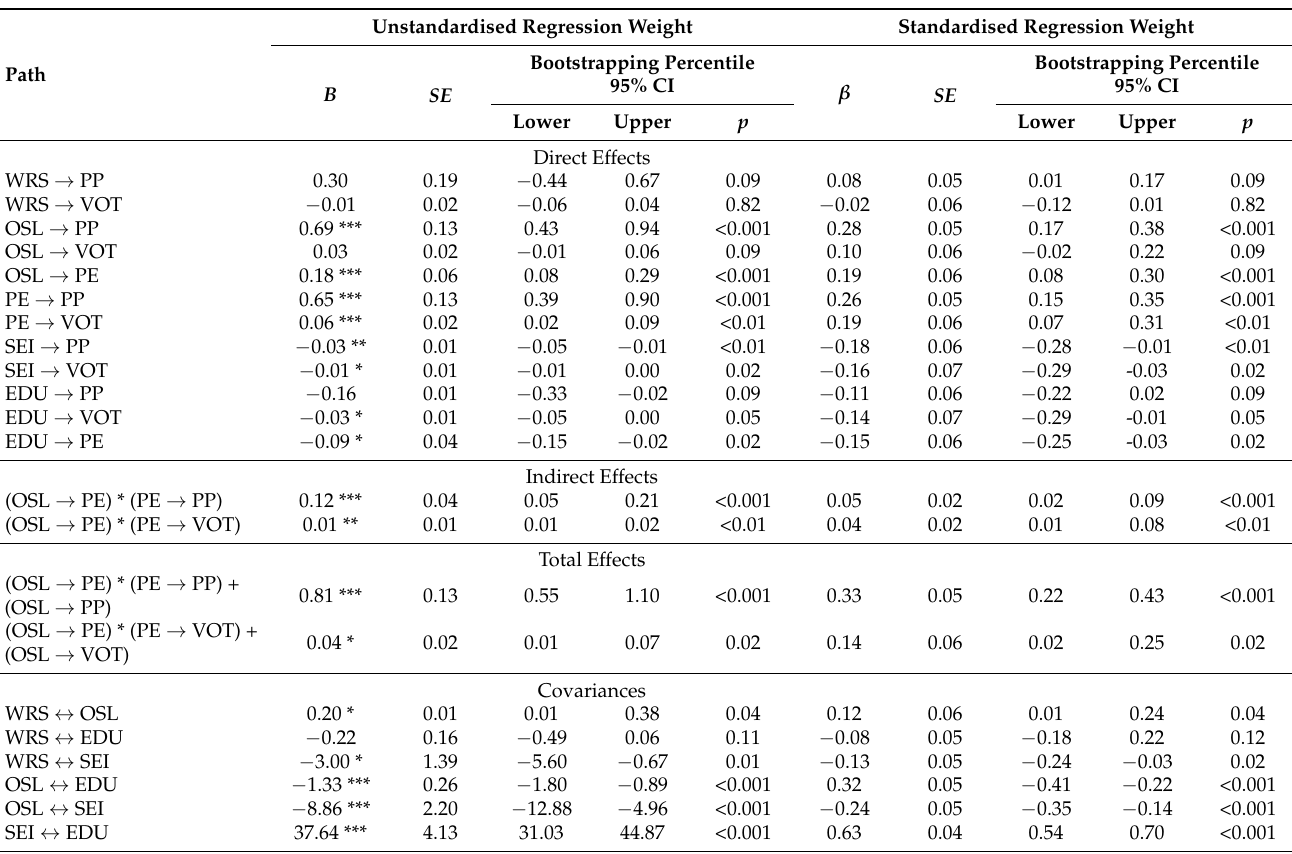
Table A1. Unstandardised and Standardised Direct, Indirect, and Total Effects and Covariances of the All Paths of the Hypothesised